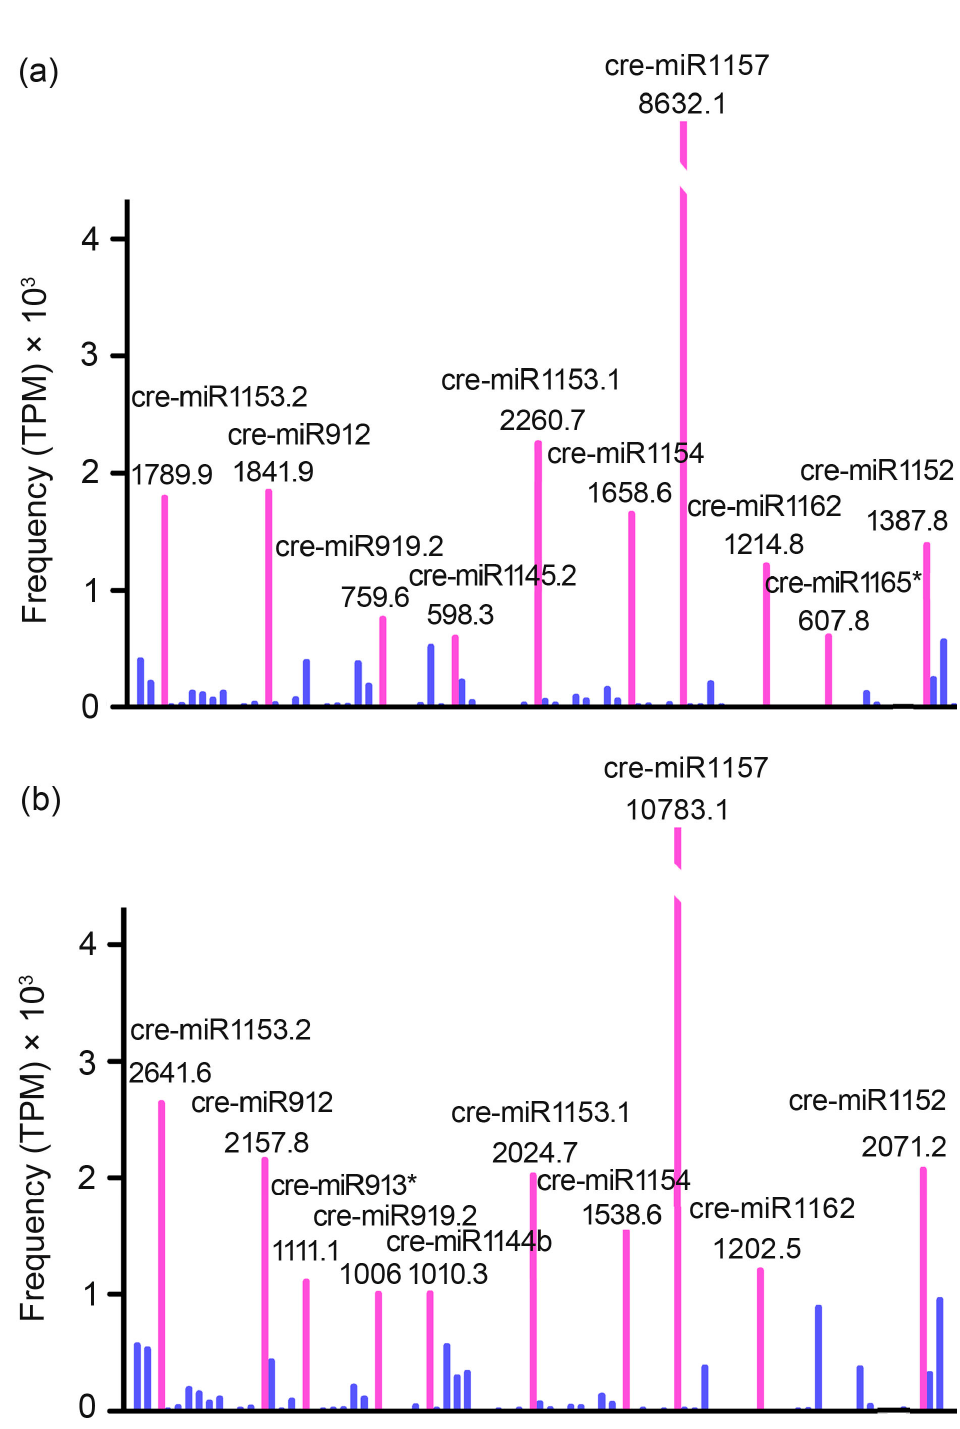
Figure 4. Abundance and differential expression of known miRNAs expressed (TPM) in C. reinhardtii . ( a ) represents the known miRNAs of C. reinhardtii cultivated in nitrogen-replete medium; ( b ) represents the known miRNAs of C. reinhardtii cultivated in nitrogen deficiency medium. Red lines indicated the TOP ten miRNAs; blue lines indicated the relatively less abundant miRNAs.